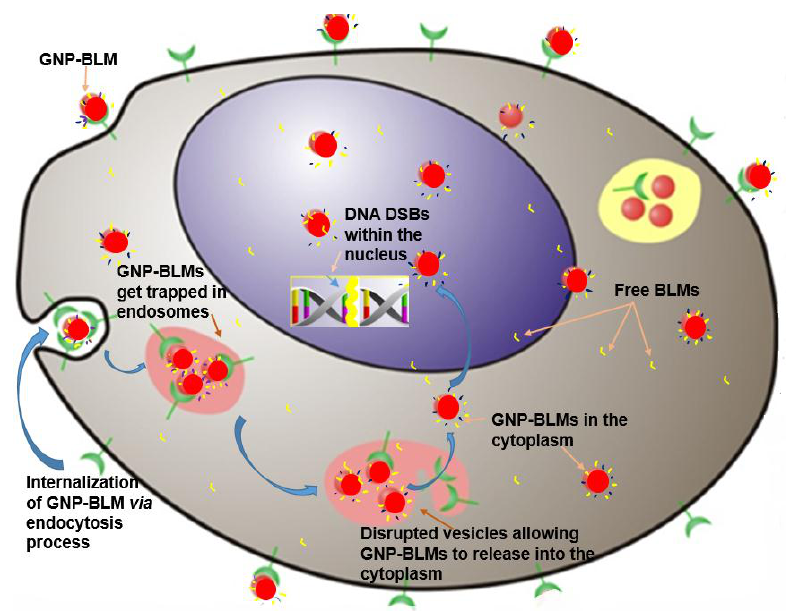
Figure 6. Schematic diagram explaining the pathway of the GNP-BLM complex. The GNP-BLM complex enters the cells via the regular endocytosis process and becomes trapped in the endo-lyso path. A peptide with an RGD domain on GNPs allows them to escape from endo-lyso path and enter the cytoplasm for nuclear delivery. BLM can also be released into the cytoplasm from GNP surface due to the changes in the physiological condition within the cell. Free BLM can also enter the nucleus as well. GNPs with BLM molecules still present on the surface could also reach the nucleus.